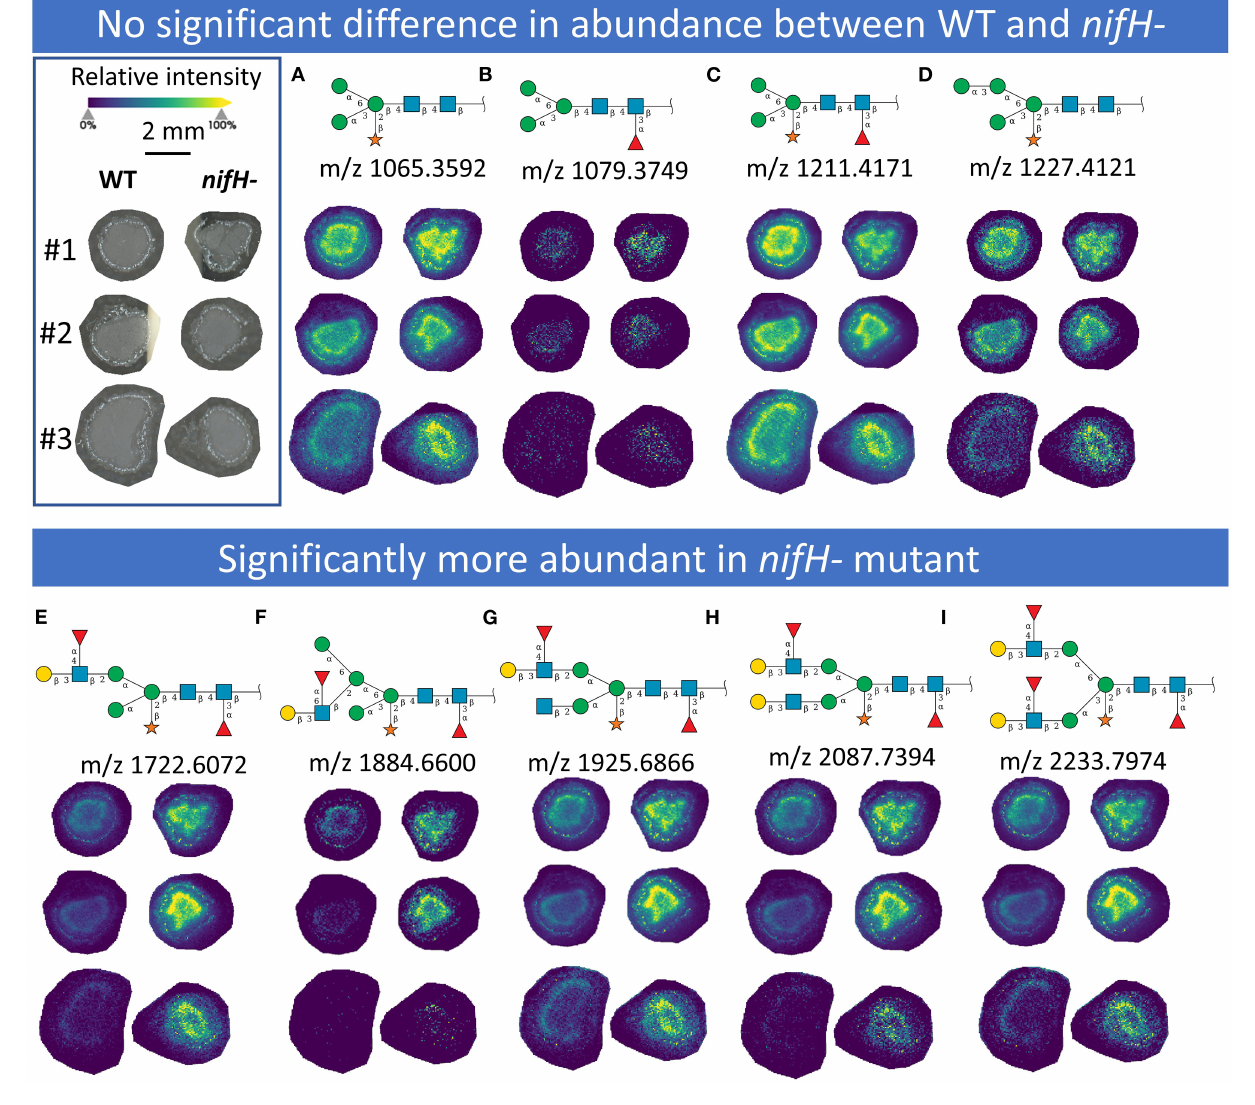
FIGURE 2 | MALDI MS images of exemplary N -glycans that (upper panel) show no significant differences in abundance between WT and nifH- mutant (A–D) and those (lower panel) that are significantly more abundant in nifH - mutant (E–I) . For each N -glycan ion images, color scale bar was created separately. Representative Symbol Nomenclature for Glycans (SNGF) and distribution patterns of three bioreplicates (#1, #2, and #3) at 50 µ m spatial resolution are shown. Glycan compositions of representative SNGF: (A) Hex:3 HexNAc:2 Pent:1, (B) Hex:3 HexNAc:2 dHex:1, (C) Hex:3 HexNAc:2 dHex:1 Pent:1, (D) Hex:4 HexNAc:2 Pent:1, (E)